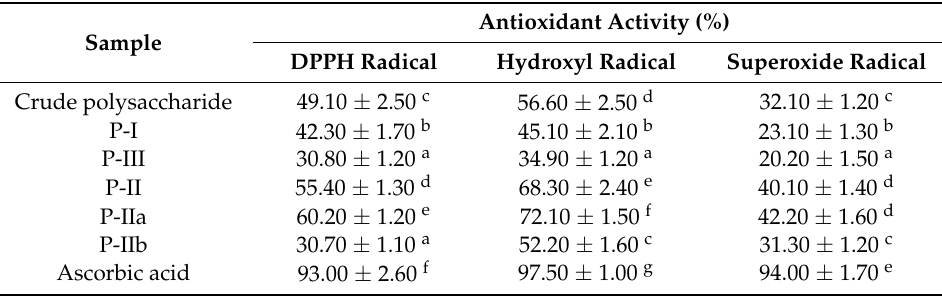
Table 3. Antioxidant activity of Chlorella -Arc polysaccharides at 5.0 mg/mL.